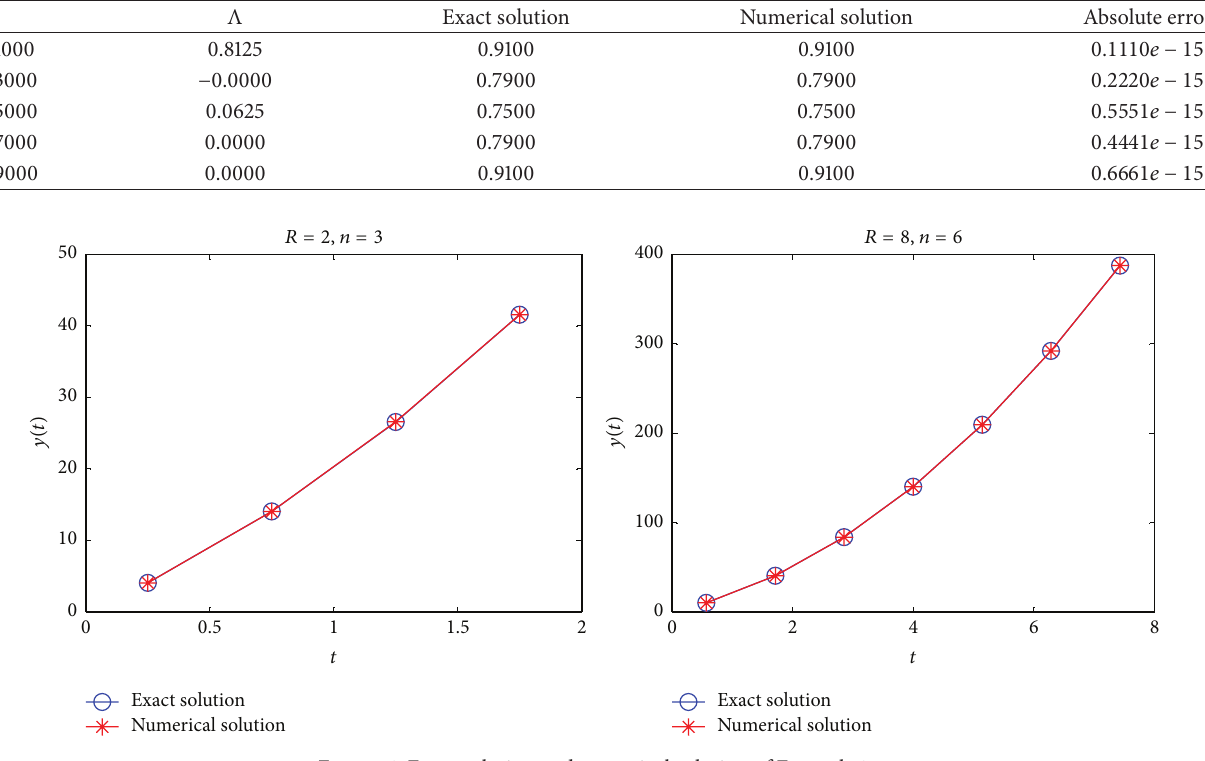
Figure 1: Exact solution and numerical solution of Example 1.